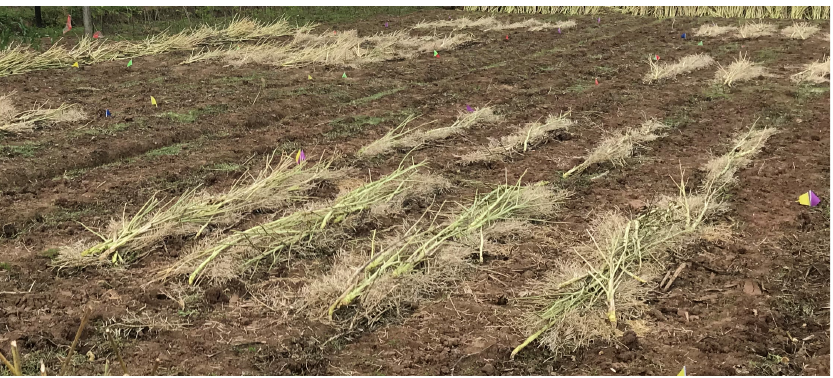
Figure 2. E ff ects of di ff erent crop residue removal rates on fi eld conditions (photographed on 30 Figure 2. Effects of different crop residue removal rates on field conditions (photographed on